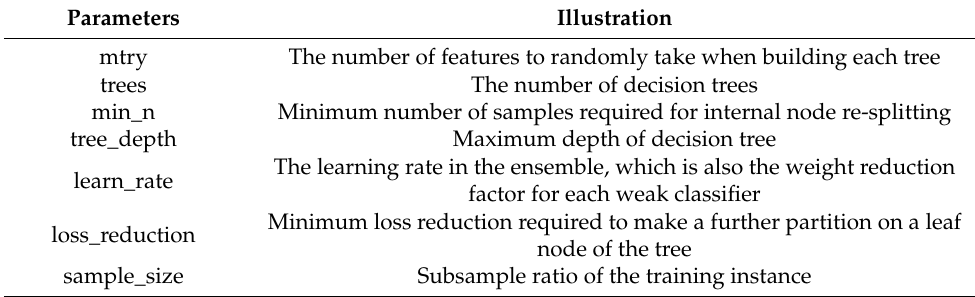
Table 3. Main parameters. Parameters